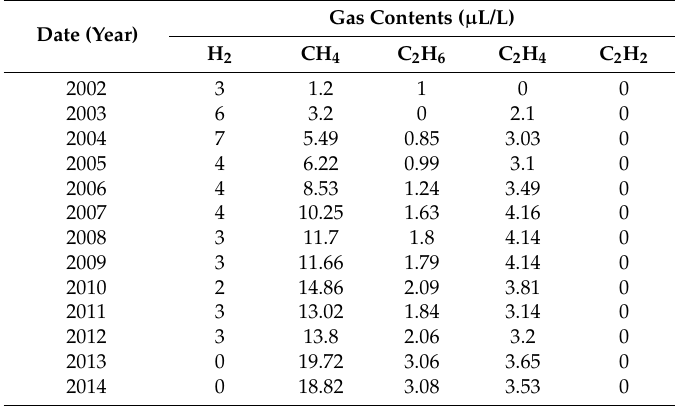
Table 3. Dissolved gas analysis (DGA) testing data from year of 2002 to 2014.